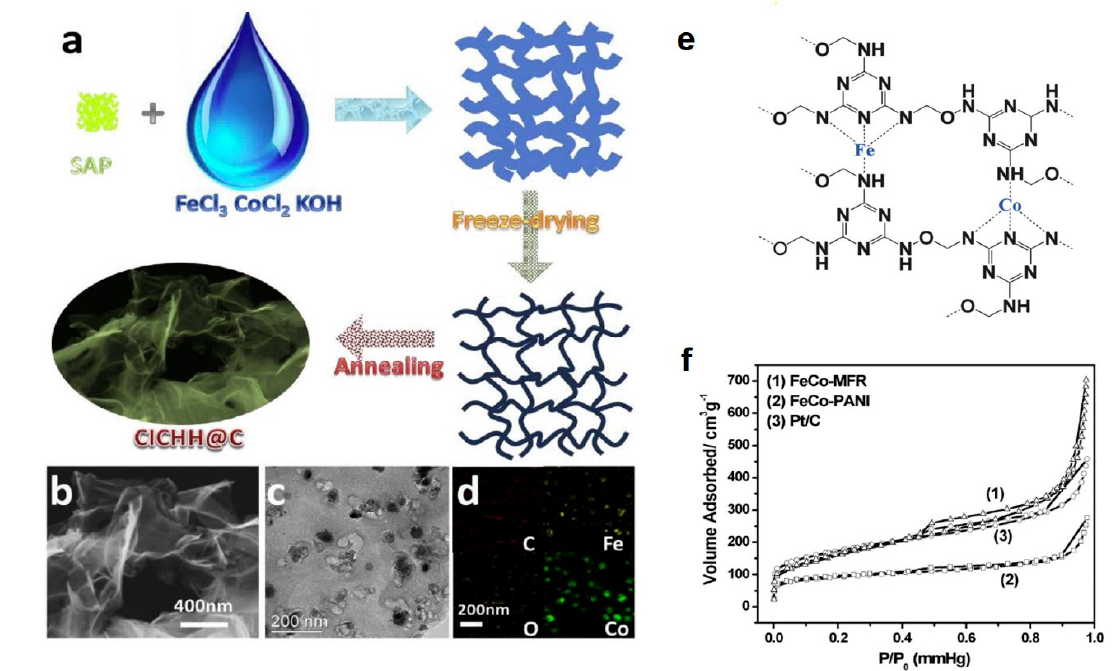
Figure 16. ( a ) The synthetic scheme of CICHH@C, ( b ) SEM image of CICHH@C, ( c ) TEM image of CICHH@C. ( d ) the C, O, Fe, and Co element mapping of CICHH@C, reproduced with